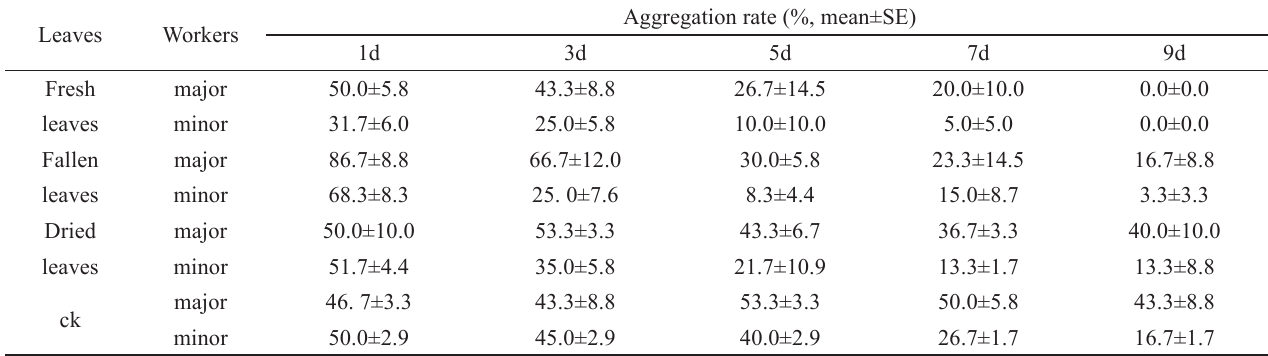
Table 5. Effects on aggregation rate of workers after treated with mashed fresh, fallen, and dried leaves of M. exotica.